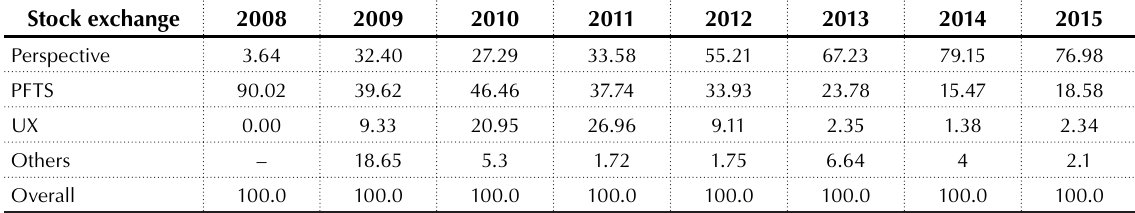
Table 1. Structure of the Ukrainian stock market by organizers in 2008–2015, % Stock exchange